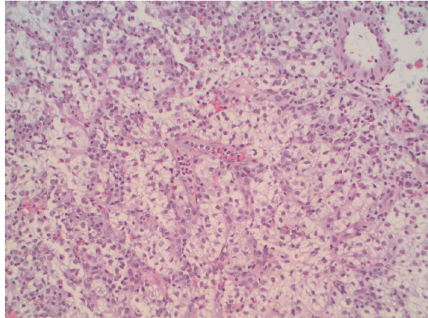
Figure 2: Histological evaluation including H&E staining, showing a tumor comprising nests and fascicles of cells with abundant clear cytoplasm and moderately pleomorphic nuclei with prominent eosinophilic nucleoli.